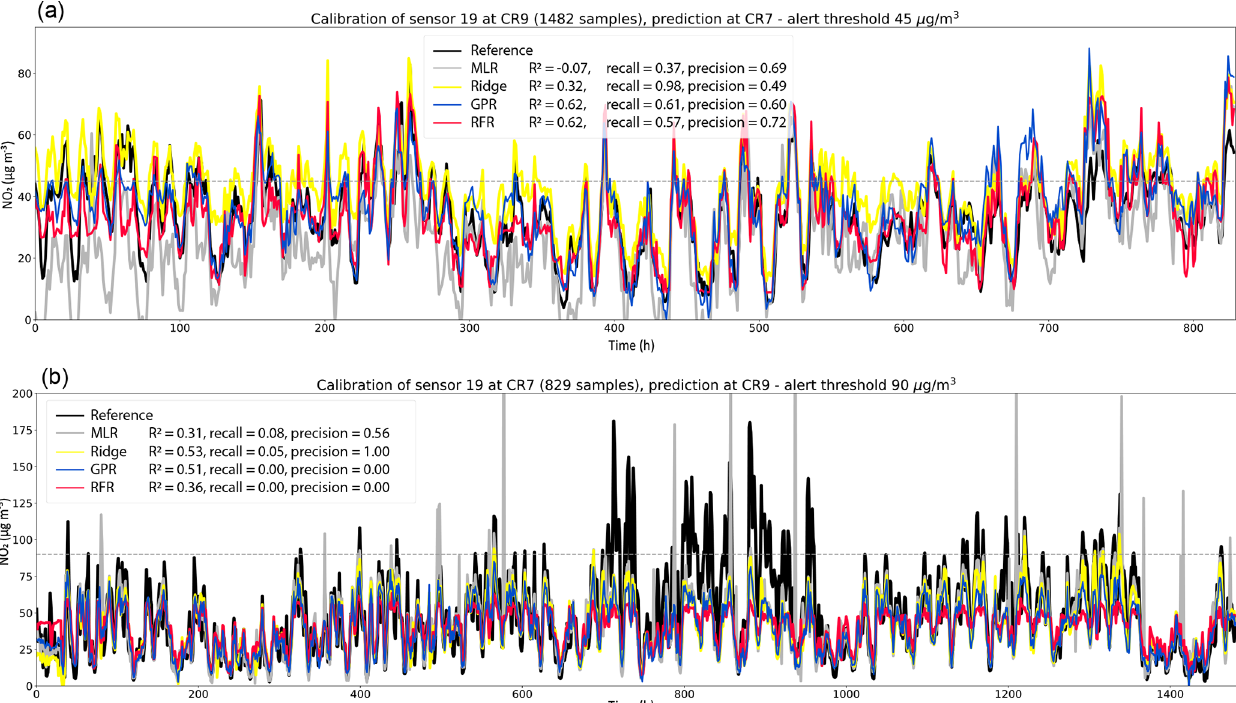
Figure 8. Tests of NO 2 sensor site transfers using calibration models trained on all available samples for locations CR7 and CR9. (a) Pre- dictions for the four regression models (as labelled) and reference measurements at location CR7, using models trained on data from CR9 and (b) vice versa. The inset values provide the R 2 scores for each method relative to the reference as well as the corresponding recall and precision for the detection of the strongest pollution events, which are typically of particular interest in real-life situations. Since the two locations were subject to very different pollution ranges (note the different value ranges on the y axes), these are defined in (a) as 45µgm − 3 and in (b) as 90µgm − 3 , and we indicate these thresholds by grey dashed lines. An extreme pollution event occurs when the threshold is exceeded for 2 of the last 3h. For compactness, we only show data for times at which both reference and low-cost sensor data were available, and we label these hours as a consecutive